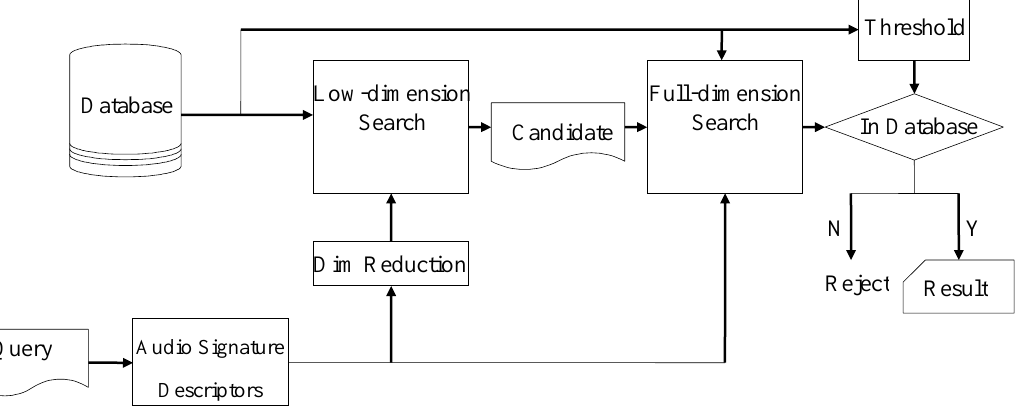
Figure 1. A multi-resolution approach